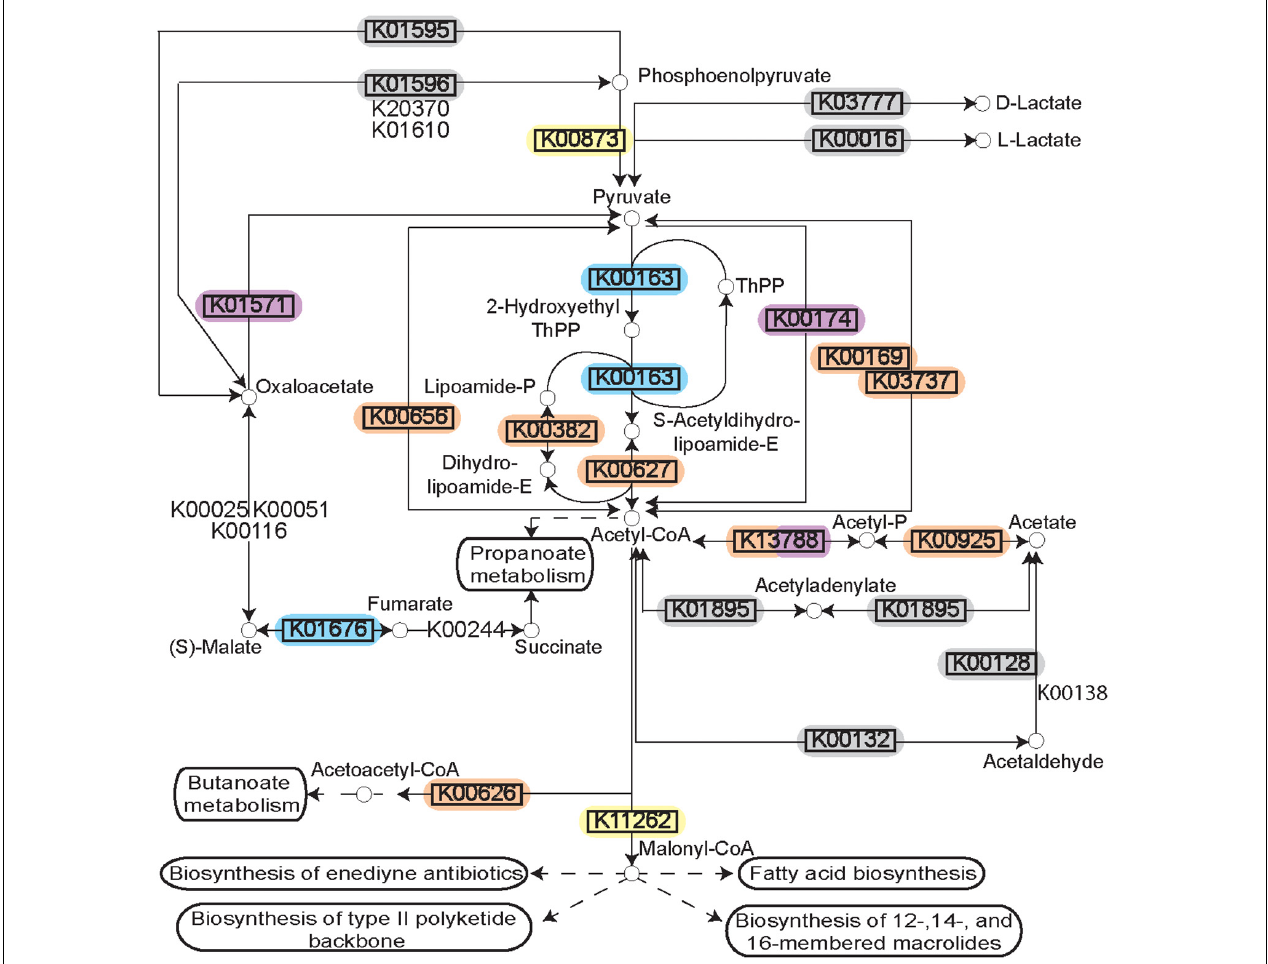
FIGURE 4 | Pyruvate metabolism during disease. Rendering of the KEGG pathway of pyruvate metabolism annotated with the DE transcripts and the microbial complexes from which they originate. Differential expression is represented by the black rectangle around the KEGG Orthology term. Background color for the KEGG orthology term represents the microbial complex of the organism that showed differential expression. The pathway as a whole is up-regulated, but the individual genes are up-regulated in diverse species supporting polymicrobial synergy during